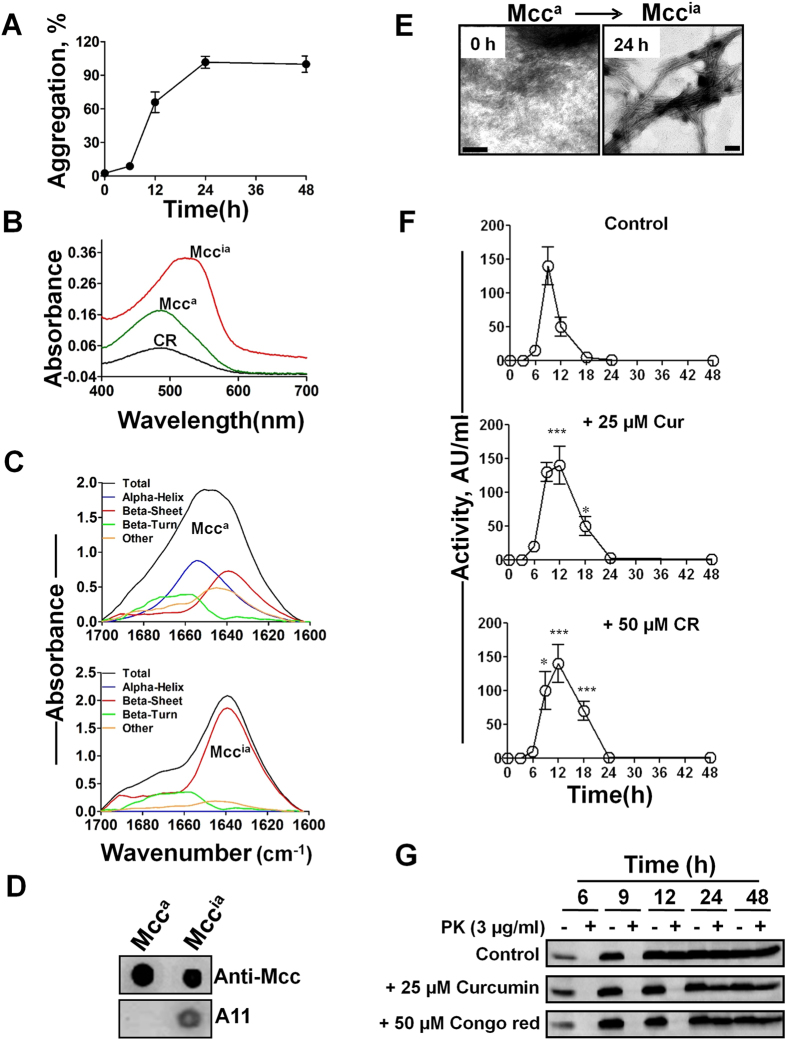
Mccia is a β-sheet rich amyloid aggregate.(A) Purified Mcca (400 μg/ml) was allowed to aggregate at 37 °C for 48 h and the extent of amyloid formation was monitored by the ThT binding assay. Experiment was done in duplicate and data correspond to the average ± S.D. (B) Absorption spectra of bound CR in the presence of purified Mcca (green line) and Mccia (red line) produced after aggregation of Mcca for 24 h at 37 °C. Black line represents CR alone. (C) FTIR spectra of purified Mcca (top panel) and Mccia (bottom panel). The black line represents the experimental spectra and the colored lines are the deconvoluted components corresponding to the various structural motifs as obtained by computer analysis. The peak assignments was as following: ~1639 and ~1691 cm−1 for β sheets; ~1654 cm−1 for α-helix; ~1648 cm−1 for random structure; ~1667,~1675 and ~1680 cm−1 for β turns29. (D) Dot blot analysis for the interaction of Mcca and Mccia with the A11 conformational antibody that recognizes β-sheet-rich soluble oligomers. (E) Ultrastructural morphologies of Mcca and Mccia under TEM after negative staining. The bars represent 100 nm. (F) Known amyloid inhibitors delay conversion of Mcca into Mccia. Mcc producing bacteria were grown in minimal medium at 37 °C until 48 h either in the absence (control), or in the presence of Curcumin (25 μM) and CR (50 μM). Aliquots were removed periodically and activity of Mcc was measured by the critical dilution method. Activity was measured in duplicate samples and error bars indicate S.D. The differences in Mcc activity between control and treated samples were highly significant (P < 0.0001) in both variables (time and treatment, as well as the interaction between them) as measured by two-way ANOVA. Post-hoc analysis by the Bonferroni test revealed also significant differences between treatment and controls at times 9, 12 and 18 h (*P < 0.05; ***P < 0.001). (G) Immunoblots of aliquots removed at different times from cultures used in panel F before (−) and after treatment (+) with PK (3 μg/ml).